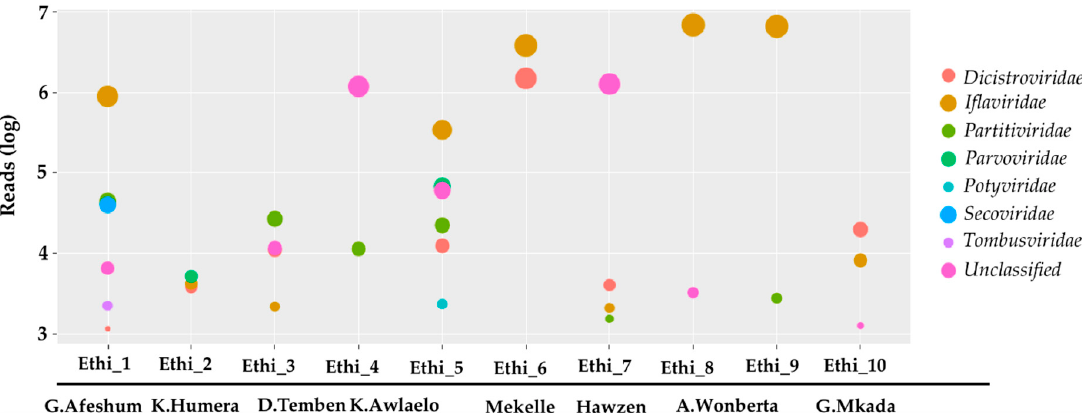
Figure 2. Identified viral families and the numbers of reads assigned to each family. Circle radii indicate the number of reads (log10 transformed) assigned to each family per sample. Ethi_1 to Ethi_10 refers to the sample code given to each apiary, and district names are given below (see Figure 1).